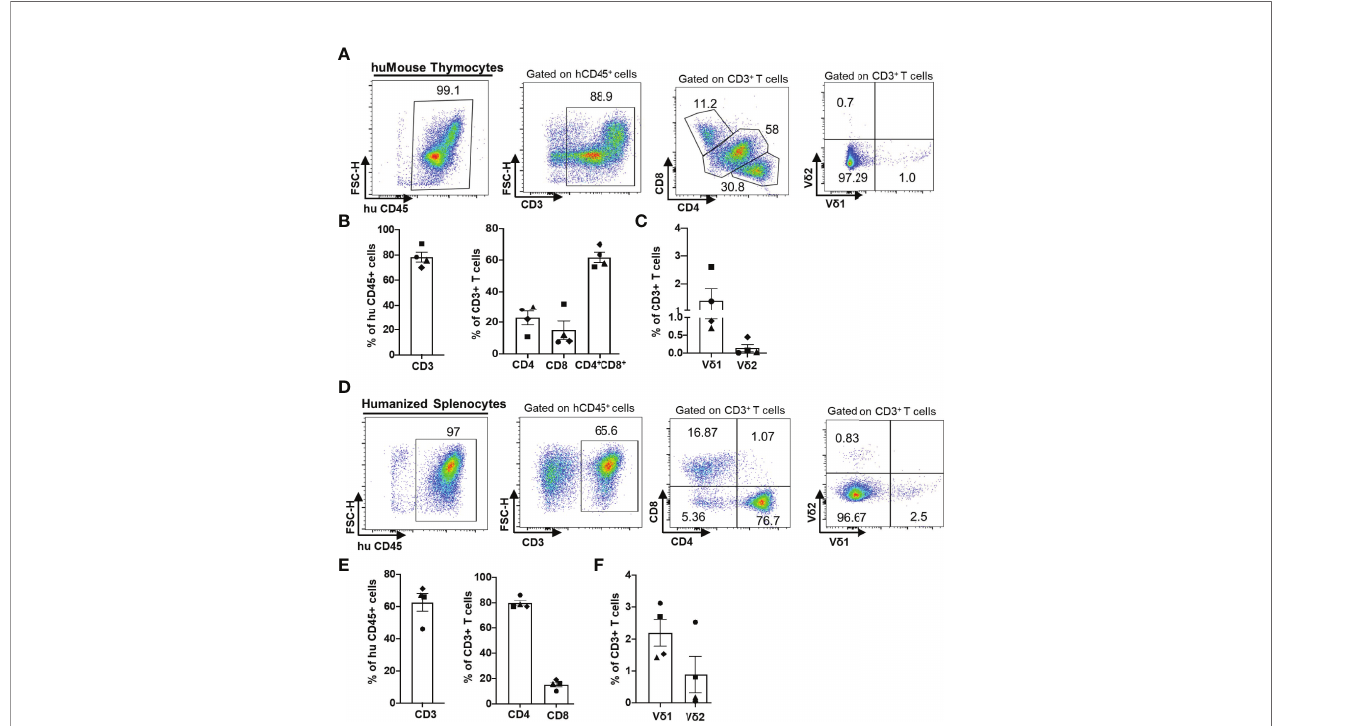
FIGURE 2 | Human ab and gd T cell development in lymphoid tissues of a BLT huMouse model. (A, D) Representative fl ow cytometry analysis of human immune cell (hCD45 + ) reconstitution along with lymphocytes subsets including ab T cells (CD3 + ), (CD4 + ), (CD8 + ) and gd T cells (V d 1 and V d 2 T cell subsets) in lymphoid tissue [thymus (A) and murine spleen (D) ] of BLT huMice (A) at 22 weeks post-transplantation. Quanti fi cation of human ab and gd T cells in the engrafted human thymus (B, C) and murine spleen tissue (E, F) of BLT huMice at 22 weeks post-transplantation (n = 4 biological